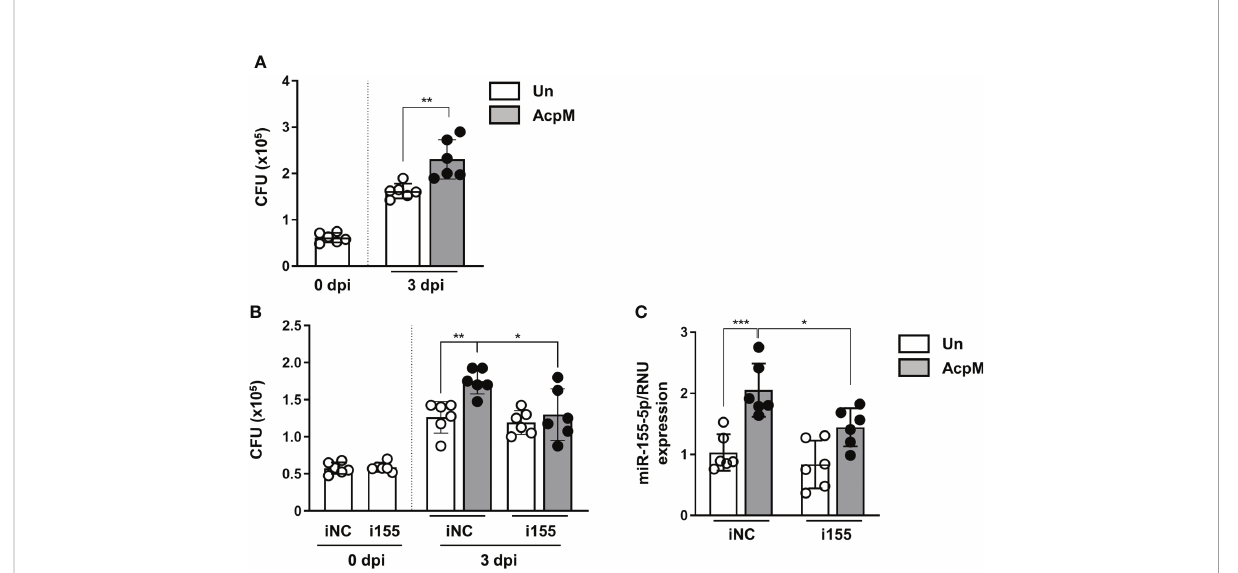
FIGURE 6 AcpM increases intracellular survival of Mtb by miR-155 upregulation. (A) BMDMs were infected with Mtb H37Rv (MOI 3) for 4 h and treated with recombinant AcpM (10 m g/ml) in the fresh media. After 3 days, cells were lysed and subjected to a CFU assay to explore the intracellular survival of Mtb. (B , C) BMDMs were transfected with either iNC or i155, then infected with Mtb H37Rv (MOI 3) for 4 h before treating recombinant AcpM (10 g/ ml) in fresh media. Cells were lysed and subjected to CFU assay at the indicated times (B) or qRT-PCR after 18 h (C) . Statistical analysis was determined with an unpaired t -test and presented as means ± SD from at least three independent experiments performed. * p < 0.05; ** p < 0.01; *** p < 0.001. iNC, negative control of miR-155-5p inhibitor; i155, miR-155-5p inhibitor. Un, untreated; AcpM,